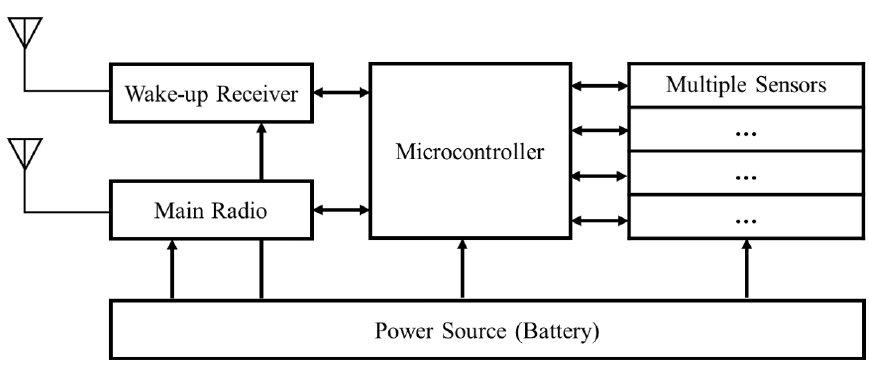
Figure 1. A wireless sensor node equipped with a WuRx, according to